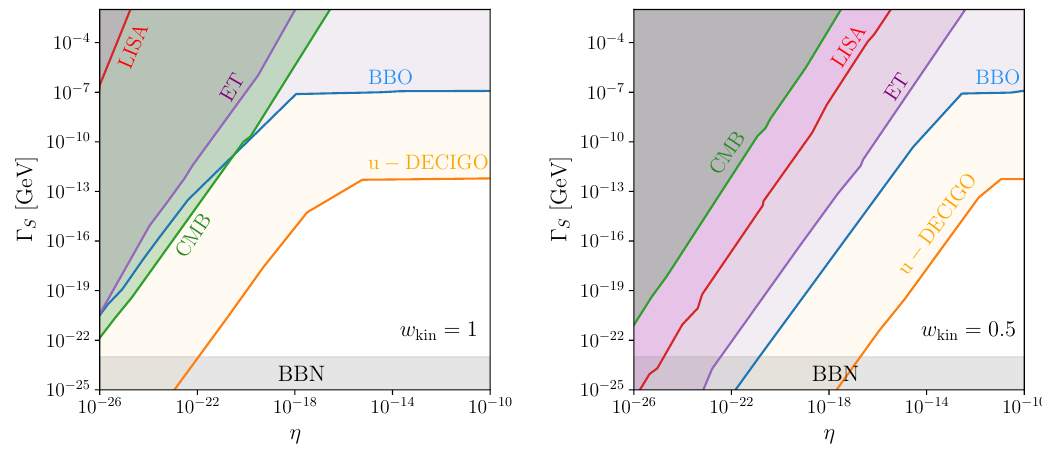
Figure 3 . The allowed region of Γ S − η parameter space from N eff bounds and future reaches in GW detectors (LISA, ET, BBO, u-DECIGO) after 4 years of exposure. The green shaded region above the green line (denoted by CMB) is disallowed by the N eff < 0 . 3 constraint. The other colored lines correspond to SNR = 1 for different GW detectors, the region above then denoting SNR > 1 . The left and right panel correspond to w kin = 1 and 0 . 5 with the other parameters fixed (cid:8) (cid:9) at { w S , H end , m DM , m S } = 0 , 6 . 6 × 10 13 GeV , 10 8 GeV , 10 12 GeV . The bottom gray-shaded area denotes the region of the parameter space where the reheaton injects entropy into the SM bath after